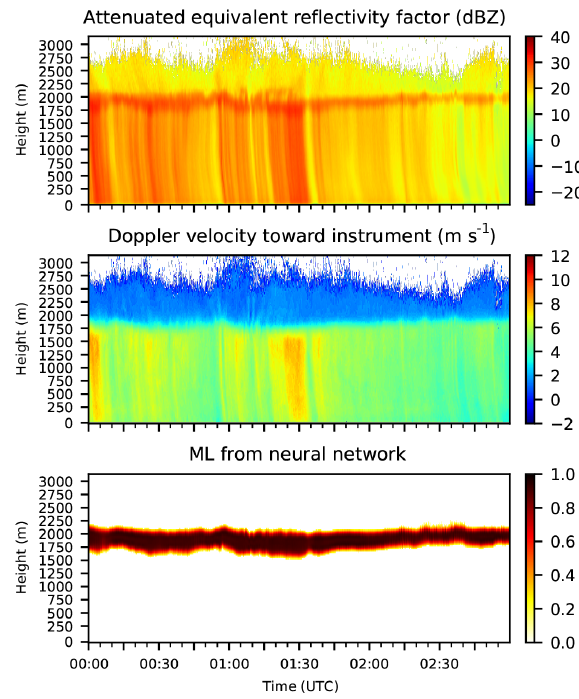
Figure 4. ZEA, VEL, and ML detected by the NN for Hohenpeißen- berg on 13 June 2018 from 00:00 to